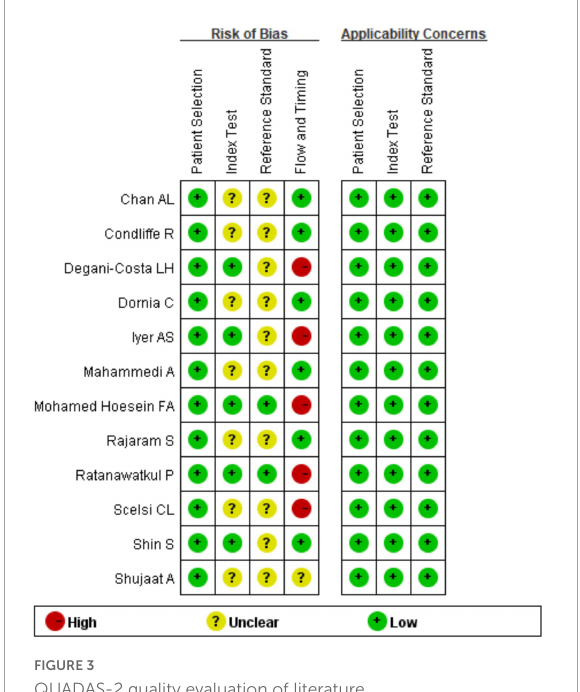
FIGURE3 QUADAS-2 quality evaluation of